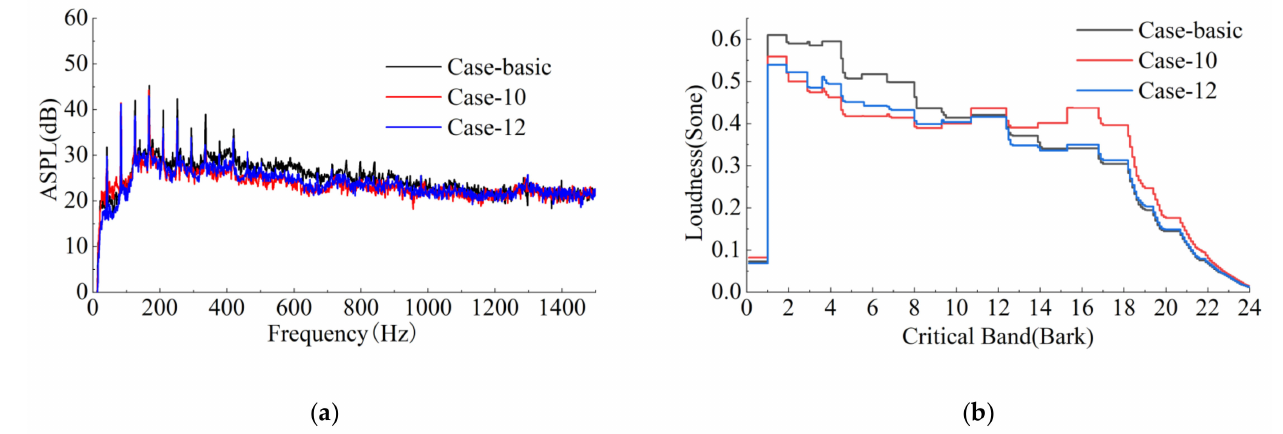
Figure 17. ASPL spectrum and loudness spectrum: ( a ) FFT frequency spectrum and ( b ) loudness spectrum. The sound-quality objective evaluation indexes loudness, sharpness, and roughness were selected as the evaluation target parameters. Loudness represents people’s